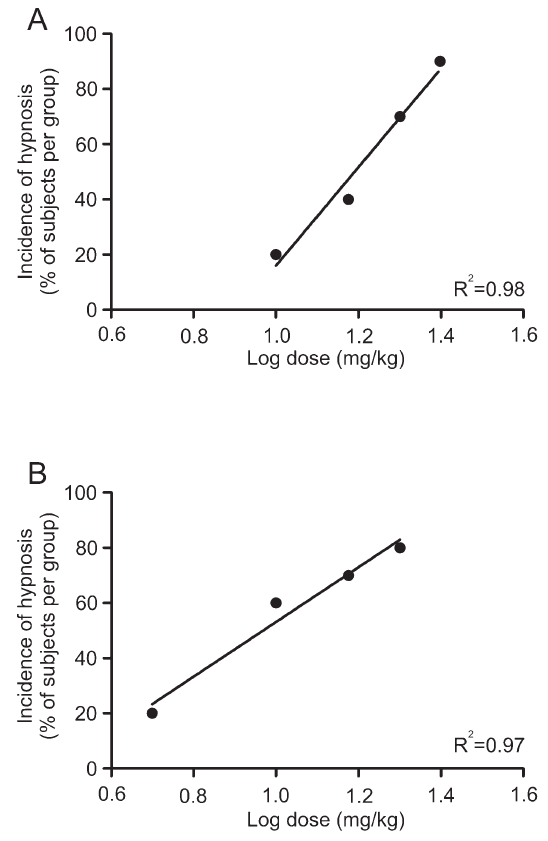
Figure 3. Incidence of hypnosis induced in mice by iv administration of different doses of ( A ) LASSBio-785 (10, 15, 20, 25 mg/kg, iv ) or ( B ) LASSBio-786 (5, 10, 15, 20 mg/kg, iv ). Simple linear regression ( c = a + b x) of the log dose-response curves was used to calculate the dose causing 50% hypnosis (HD 50 ). Each point represents the percentage of subjects presenting hypnosis in the group (n =